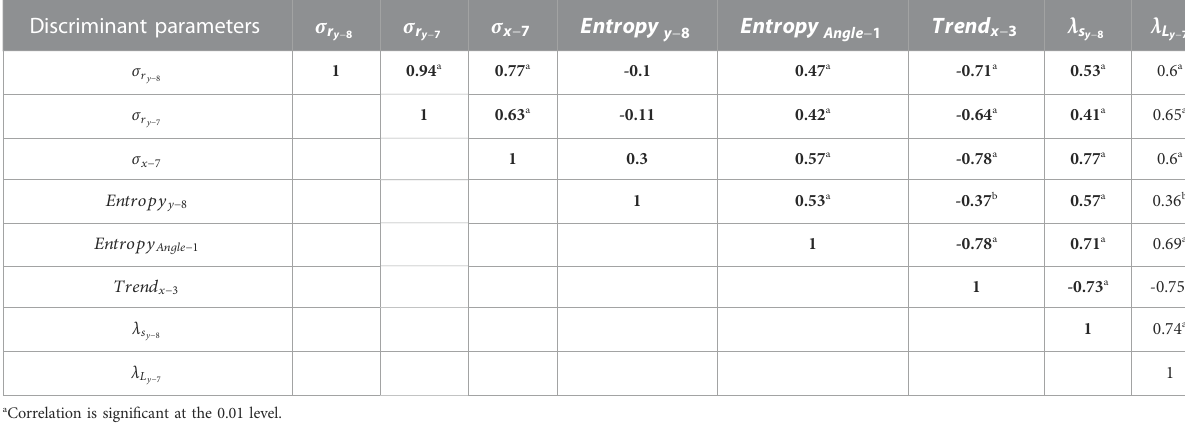
TABLE 4 Correlation matrix for LDA analysis representatives. Discriminant